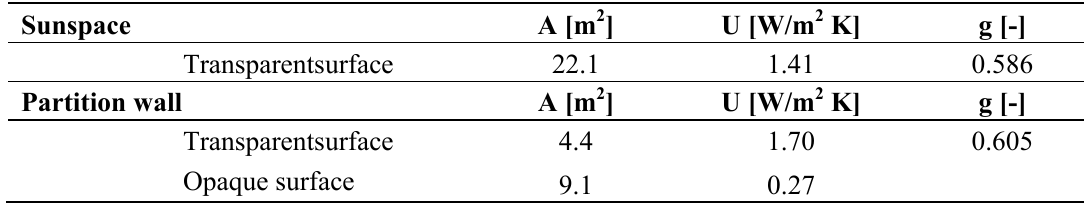
( a ) ( b ) Table 1. Thermal and geometrical characteristics of the sunspace and the wall of the model used for the dynamic